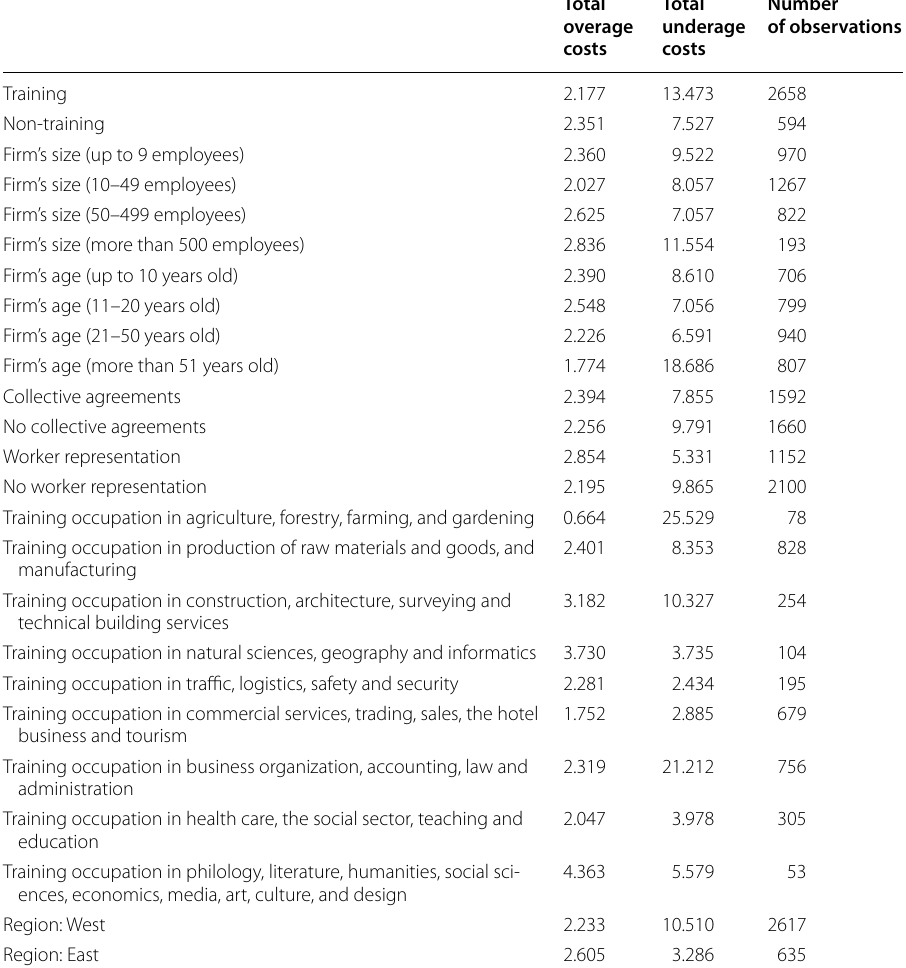
Table 2 Descriptive statistics—details (subsamples). Source BIBB CBS